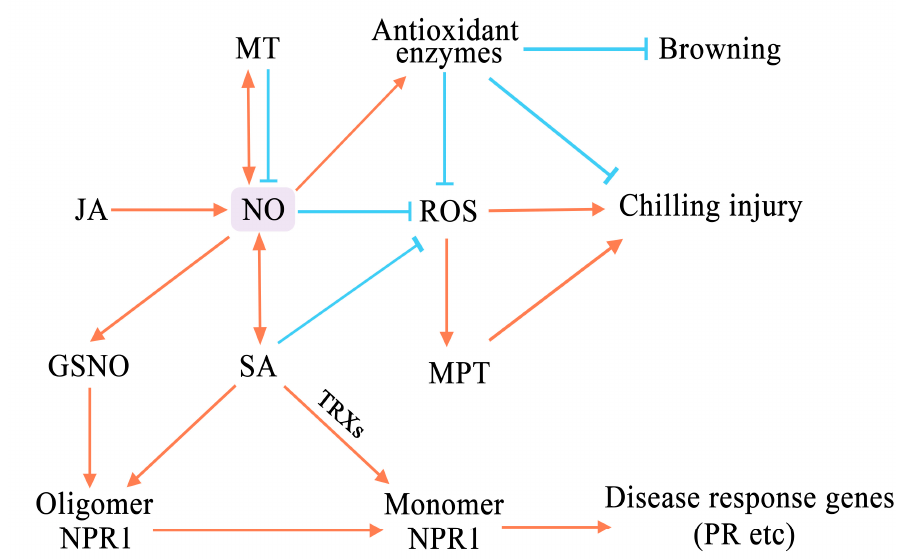
Figure 3. A model for the regulation of NO on browning, chilling injury, and disease resistance of postharvest fruits and vegetables. JA, MT, and SA can interact with NO to resist these stresses. NO promotes the activity of antioxidant enzymes to inhibit browning and alleviate chilling injury. ROS is a key regulator of chilling injury that can directly induce chilling injury or indirectly increase the MPT. NO, SA, and antioxidant enzymes can remove excess ROS. The NO donor GSNO can trigger the oligomerization of NPR1, and SA can maintain protein homeostasis. TRXs can catalyze SA-induced NPR1 oligomer-to-monomer reactions, and then the monomer NPR1 enters the nucleus to induce the expression of disease response genes. JA: jasmonic acid; MT: melatonin; SA: salicylic acid; GSNO: S –nitrosoglutathione.